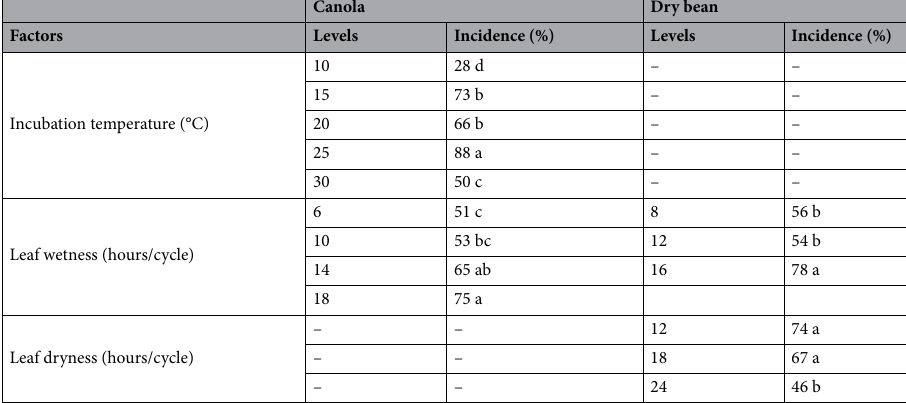
Table 2. Main effects of discontinuous leaf wetness duration and incubation temperatures on incidence (%) of foliar lesions caused by Sclerotinia sclerotiorum ascosporic infection on canola and dry bean plants. On canola, a successive wet and dry period adds to a cycle of 24 h; in dry bean, the cycle does not necessarily add to 24 h. Incidence values are least square means that represent 24 and 34 observations on canola and dry bean plants, respectively. Incidence was measured after 8 and 10 days of incubation of canola and dry bean plants, respectively. Incidence means followed by same letters in a factor are not statistically different ( α = 0.05) from each other according to the Tukey–Kramer test. A “–” indicates levels of the factor were not tested.